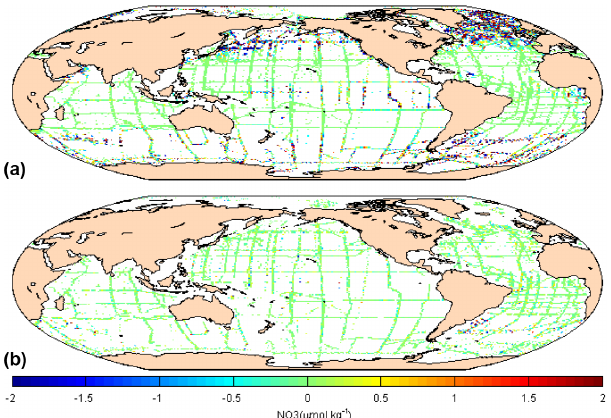
Figure 9. Mapping error for TCO 2 at 10m (a) and 3000m (b) . Notice how the error increases with distance from transects, creating a spatial pattern of square-like features in the Pacific.